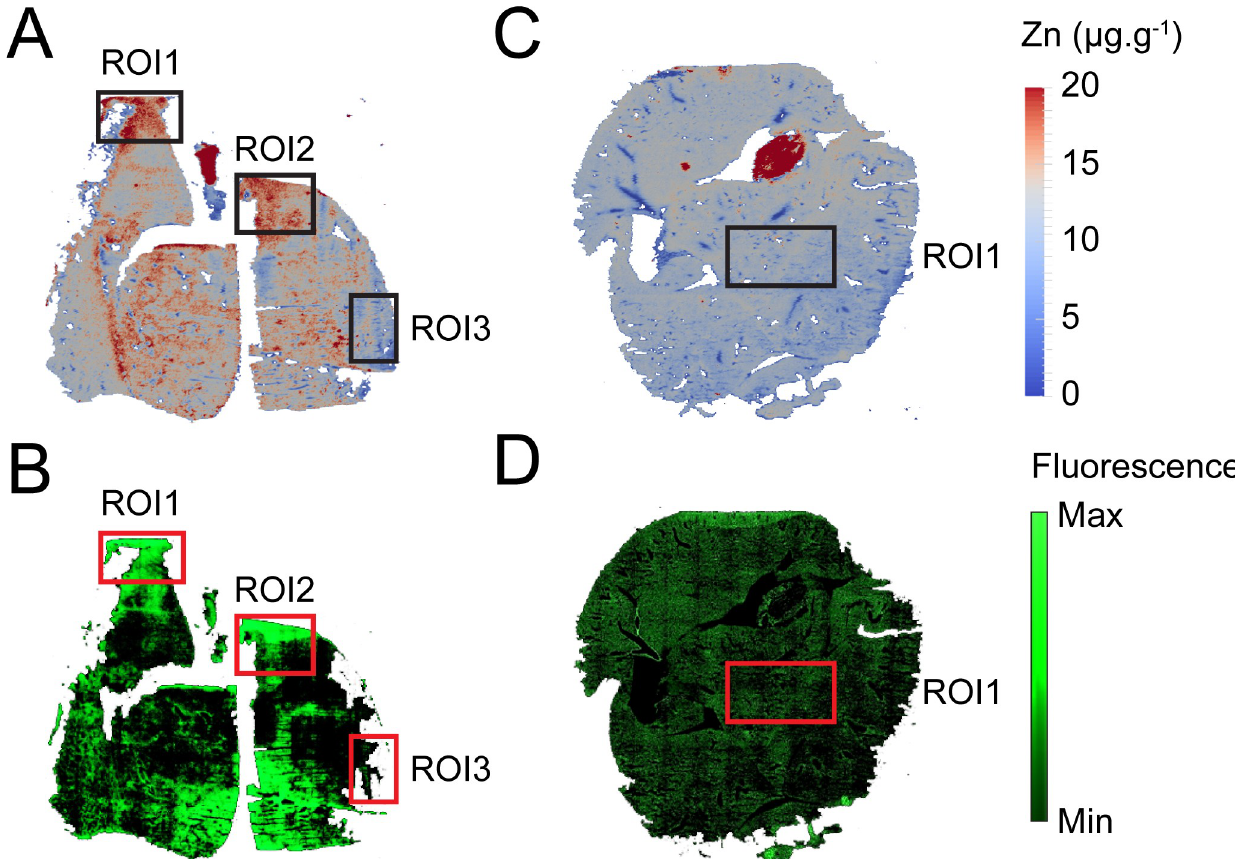
Fig 2. Co-localisation of S . pneumoniae and Zn in murine lung tissue. Spatial distribution of Zn in the lungs of infected Zn-replete (A) or na ï ve Zn- replete (C) mice at 36 hrs post challenge. These data are representative elemental maps of murine tissue sections from at least two distinct murine samples by laser-ablation-ICP-MS with quantitated regions of interest (ROI) highlighted. The scale bar represents a heat map (blue to red) for the intensity of Zn from 0 to 20.0 μ g.g -1 . Spatial distribution of S . pneumoniae pVA838-GFP fluorescence in the lungs of infected Zn-replete (B) or na ï ve Zn-replete (D) mice at 36 hrs post challenge. The data are representative murine tissue sections from at least two distinct murine samples analysed by fluorescence microscopy with regions of interest (ROI) highlighted. The scale bar represents a heat map (black to green) for the relative fluorescence intensity.